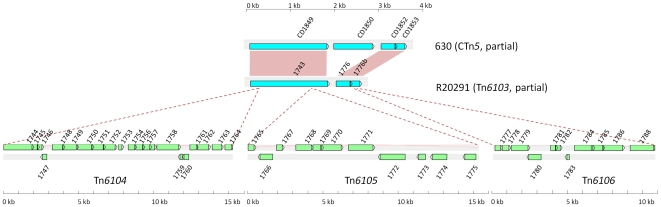
Schematic representation of Tn6104, Tn6105 and Tn6106 in Tn6103.Comparison of CD1849–CD1853 of CTn5 in strain 630 and the homologous region of Tn6103 in R20291 (see Figure 8 for a diagram of the whole of CTn5). Homologous genes are shown by red boxes. The three separate insertions in Tn6103, are shown by dotted lines.